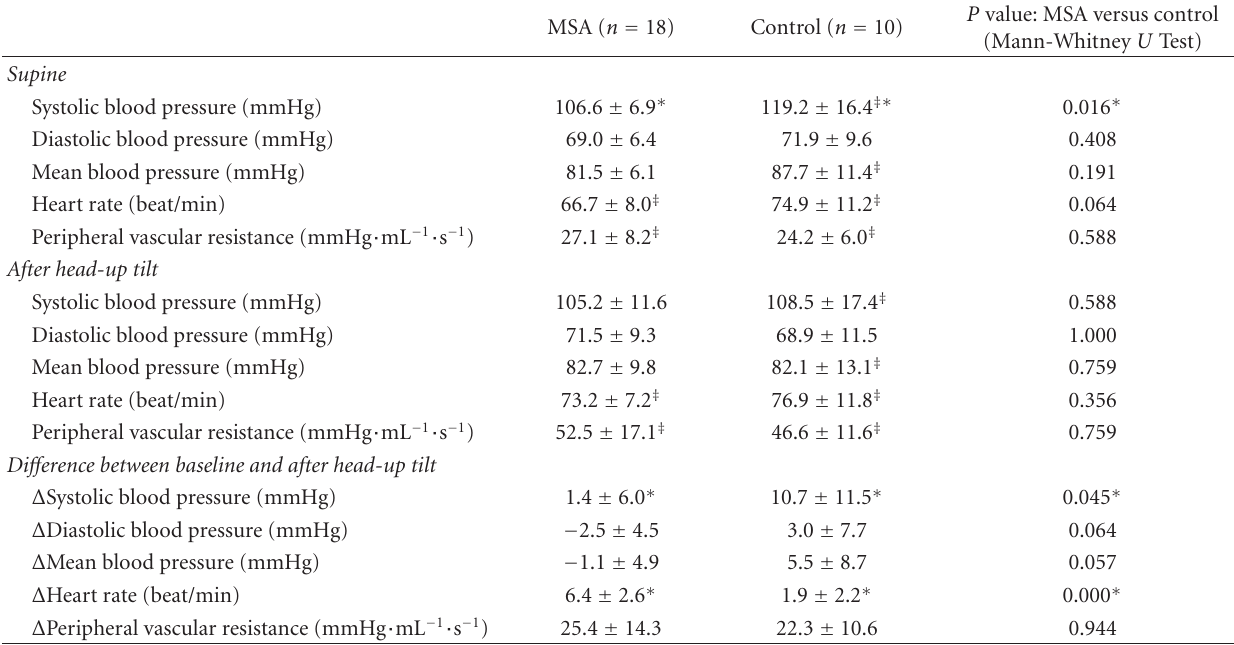
Table 3: The hemodynamic variables of the tilt table study and their corresponding changes at supine and after head-up